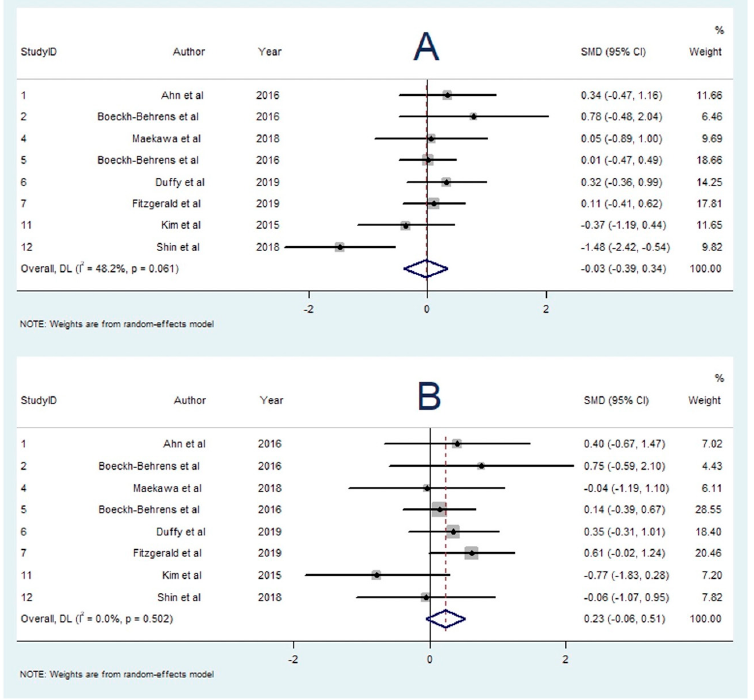
Figure 5. Forest Plots of Meta-analyses on WBC Content and Aetiology. ( A ): Cardioembolic vs. LAA Stroke. ( B ): Cryptogenic vs. LAA Stroke. Abbreviations: DL: DerSimonian and Laird method, SMD: Standarized Mean Difference, CI: Confidence Interval, WBC: white blood cell; LAA: Large Artery Atherosclerosis.